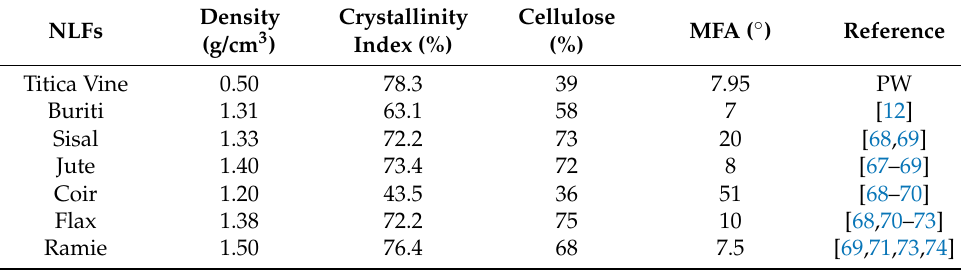
Table 4. Density, crystallinity index, cellulose content and microfibrillar angle of TVFs compared to other NLFs.